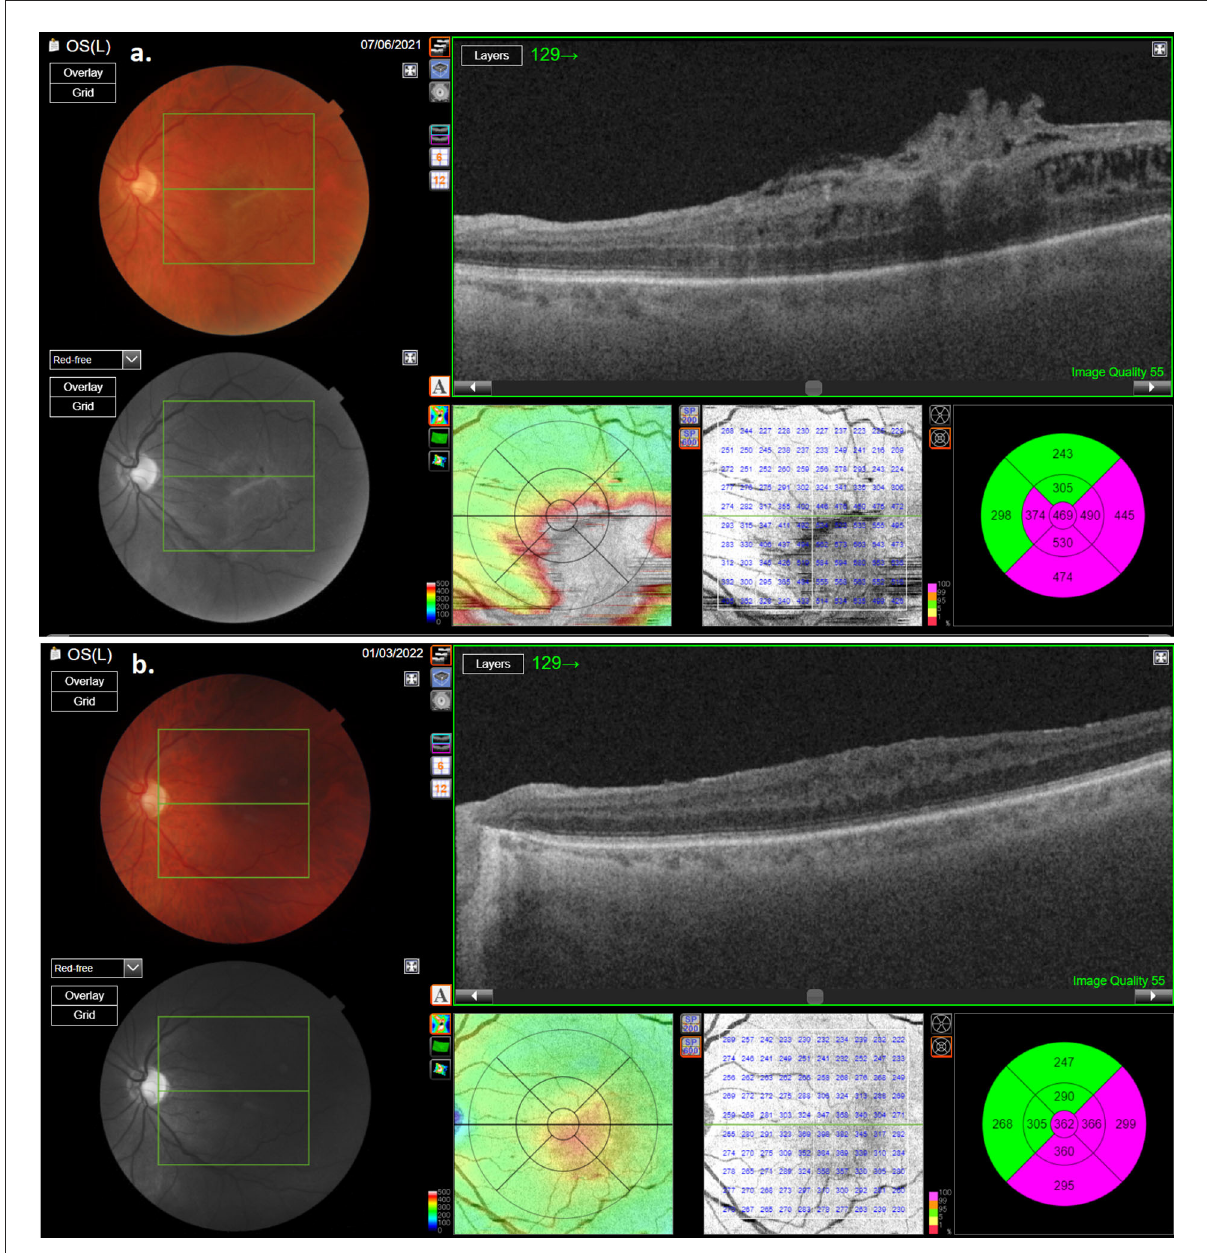
FIGURE4 OCT scan of the second patient with macular pucker: (a) pre-operative OCT; (b) post-operative OCT showing reduction of retinal thickness.